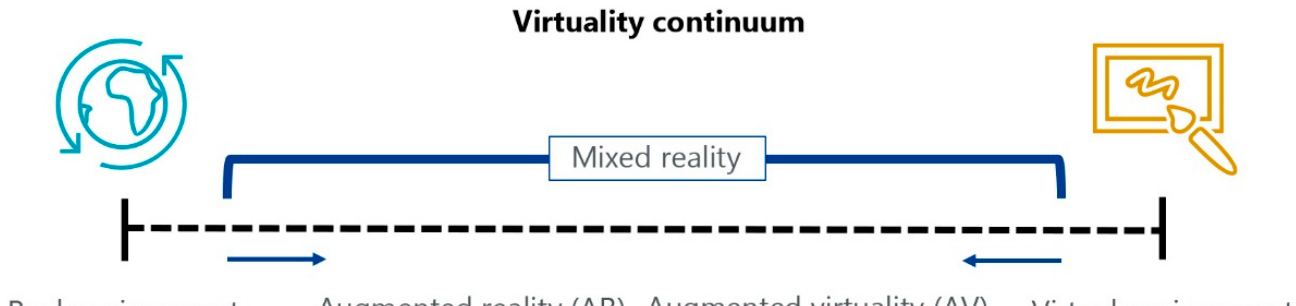
Figure 1. The virtuality continuum described by Milgram and Kishino.